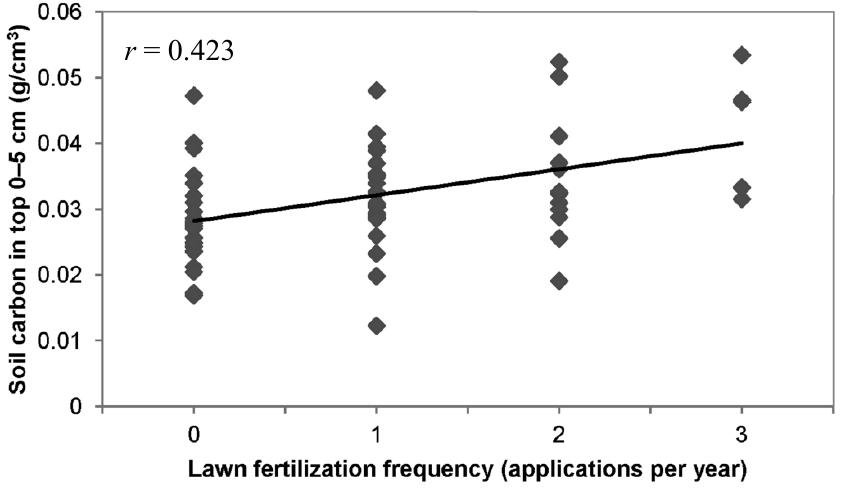
Figure 3. Correlation between C content in the upper 0–5 cm of lawn soil and the lawn fertilization frequency reported by homeowners for residential parcels developed in mixed oak forests in the Valley and Ridge physiographic province of southwest